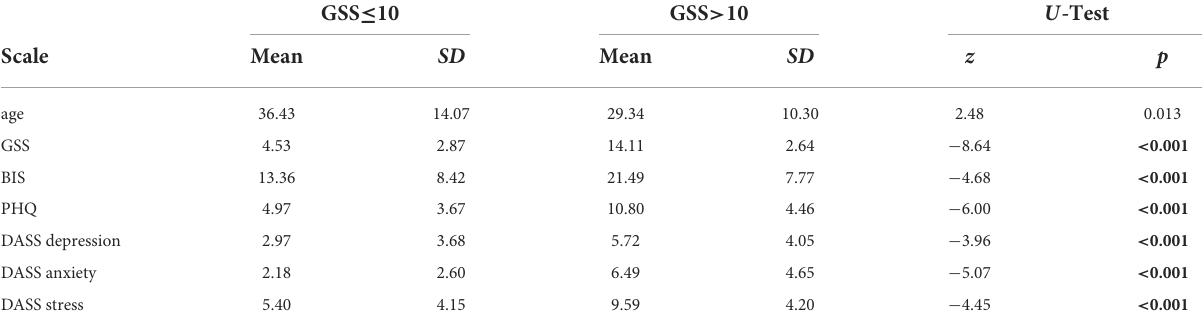
TABLE 1 Psychometric characteristics of the sample separately for the low and high-seasonality